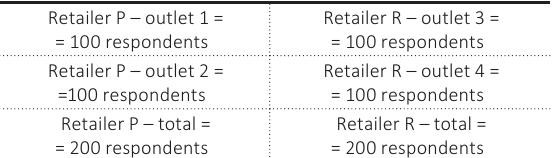
Table 1. Sample size breakdown